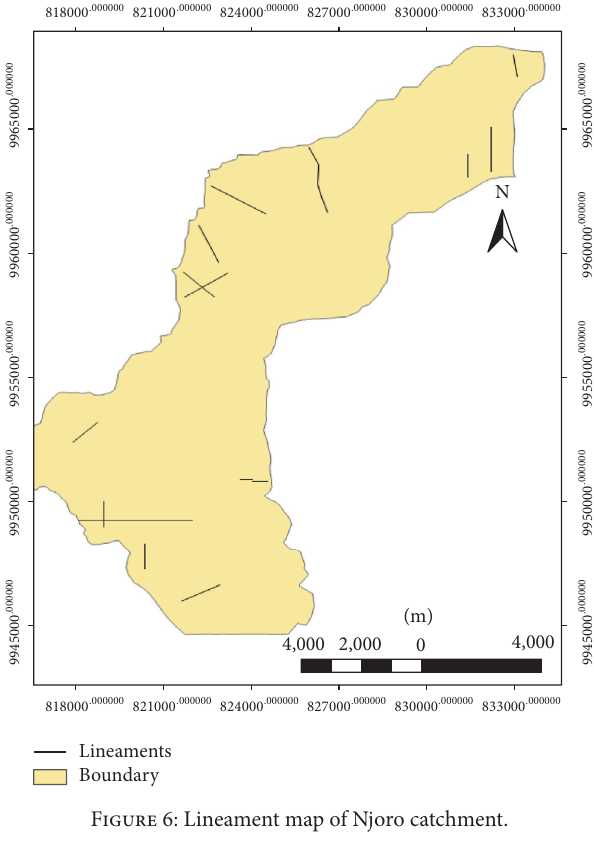
Figure 6: Lineament map of Njoro catchment.